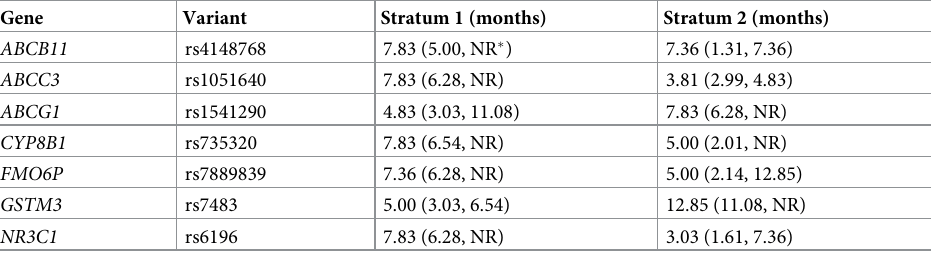
Table 3. Median progression-free